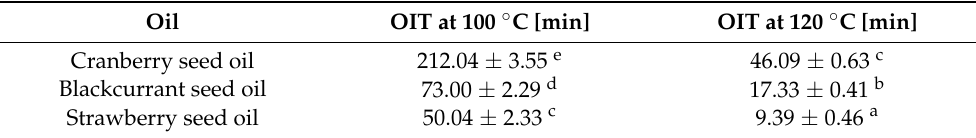
Table 5. Oxidation induction time (OIT) of cranberry, black currant and strawberry seed oils at 100 ◦ C and 120 ◦